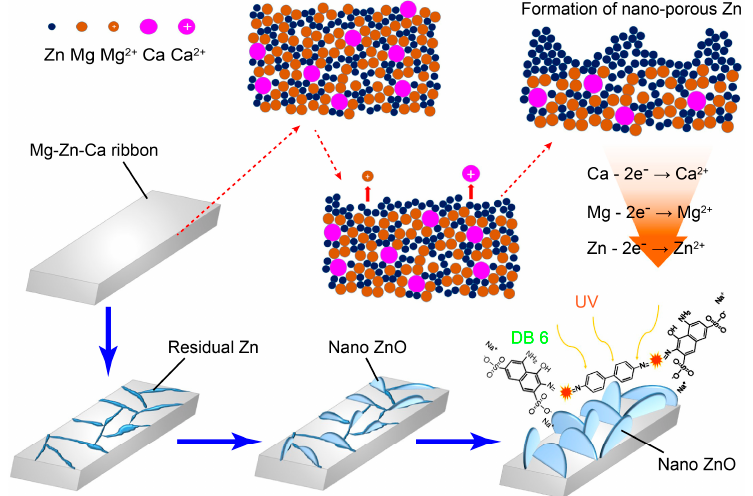
Figure 5. A schematic picture showing the mechanism in degrading azo dyes driven by the formation of ZnO nano-plates on the surface of MZC MG ribbon, the red sparkles refer to the breaking of azo bonds.